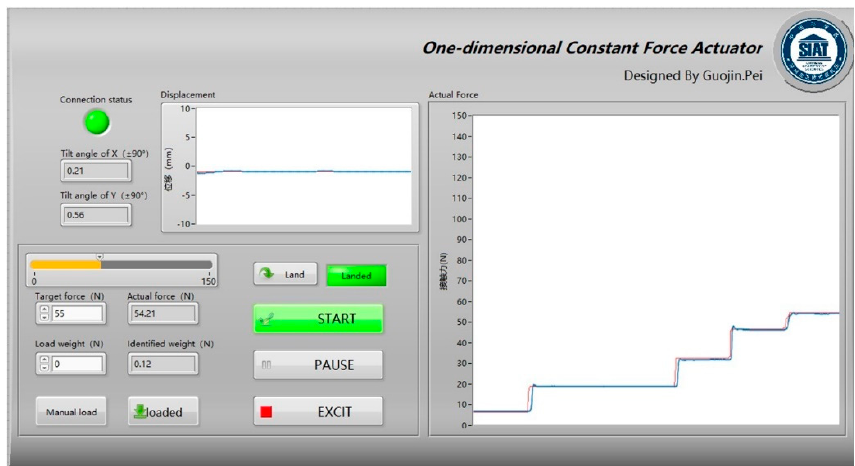
Figure 15. Software interface diagram in Labview.